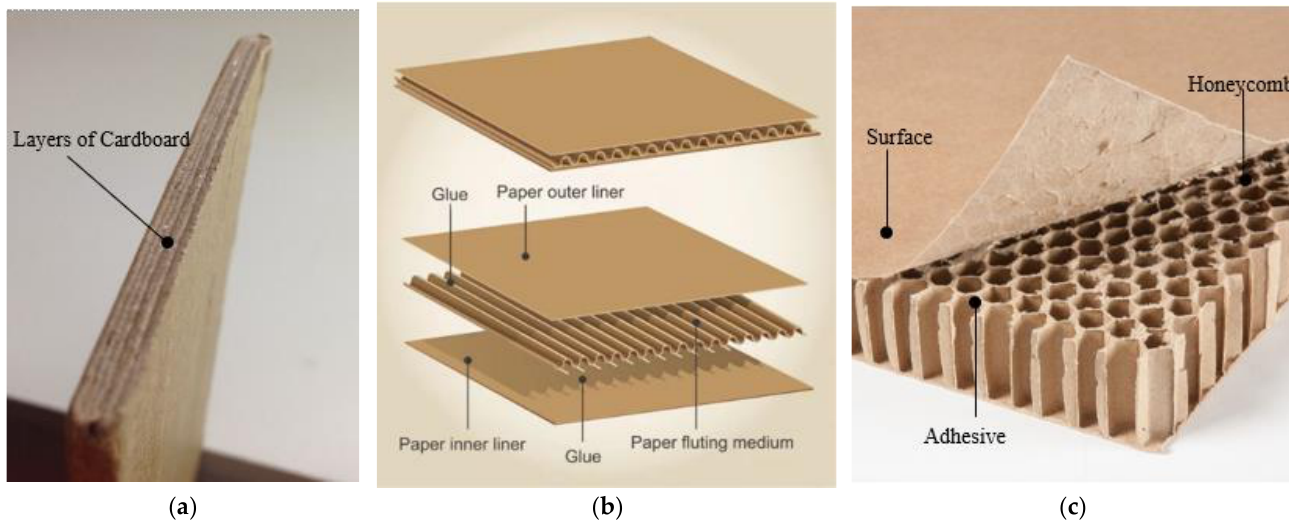
Figure 4. Cardboard patterns: ( a ) solid paperboard [59], ( b ) corrugated, [60] ( c ) honeycomb [61]. Cardboard tubes are mainly created from solid cardboard, and it is usually in cylin- drical shapes that are bonded together by adhesives. It is successfully used as structural